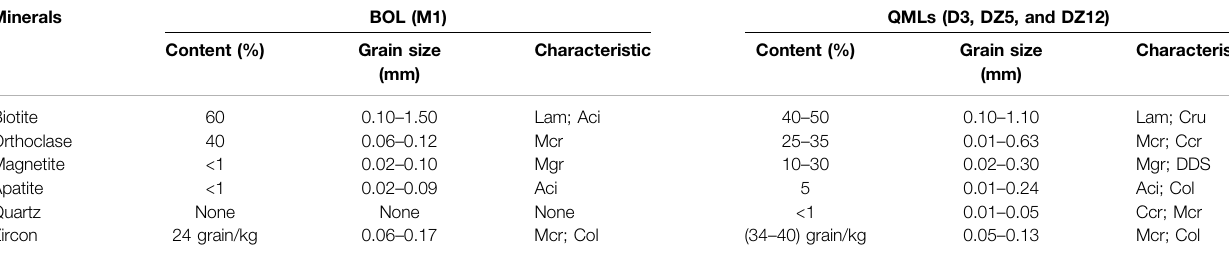
TABLE 1 | Mineral composition and characteristics of lamprophyres under